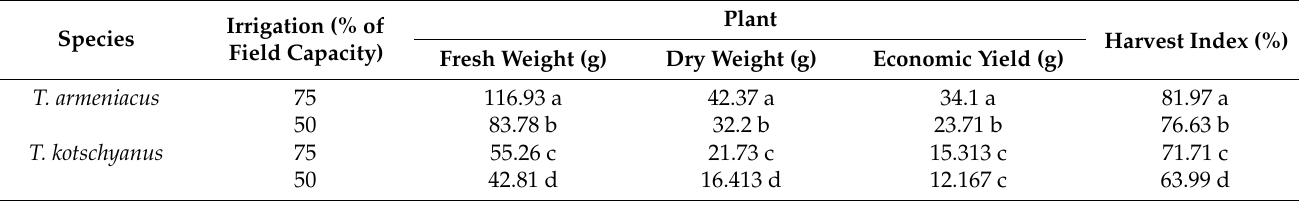
Table 3. Effect of irrigation regime on plant (fresh and dry) weight, economic yield (dry mass of leaves × 100%) of two Thymus species. Assessments were and flowers) and harvest index ( economic yield plant dry weight conducted at 100% flowering. Within each column, different letters indicate significant differences ( n = 3).